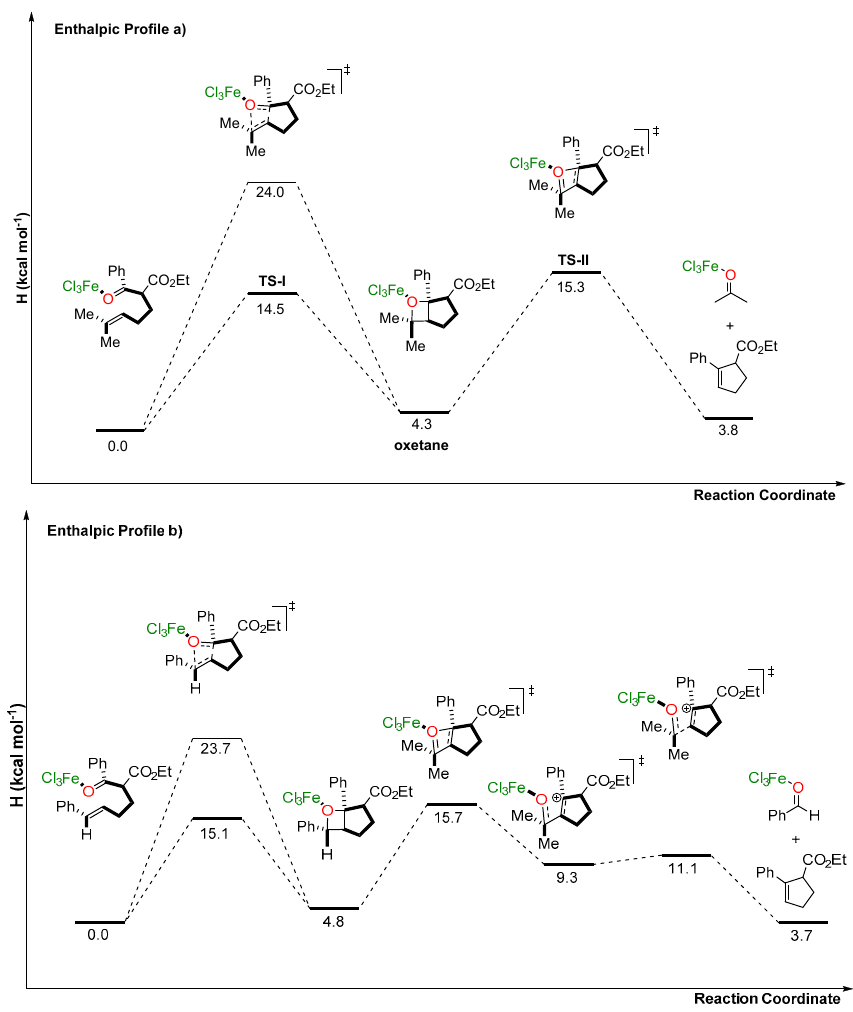
Figure 1. Reaction profiles of the two possible reaction pathways calculated by the research group of Zimmermann.